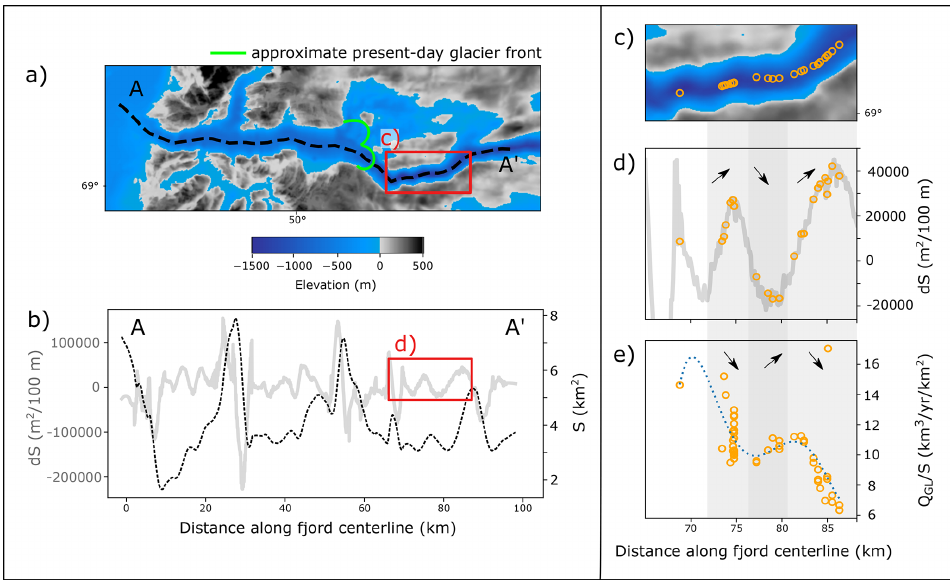
Figure 8. The real-world example Jakobshavn Isbræ. (a) Topography of Jakobshavn Isfjord (Morlighem et al., 2017) with approximate present-day glacier front and centerline along which profiles shown in (b) of the wetted area S and its along-fjord change d S are calculated; (c) zoom to area where JI is enclosed between fjord walls, with yellow circles showing all modeled grounding line positions in this section (Kajanto et al., 2020); (d) d S profile in the same section of the fjord with grounding line positions indicated; (e) Q GL /S in this section with grounding line positions and a polynomial fit (dotted blue line). The opposing trends in d S (d) and Q GL /S (e) as indicated by the arrows demonstrate qualitatively that the negative relationship Q GL /S over d S can be found in this complex